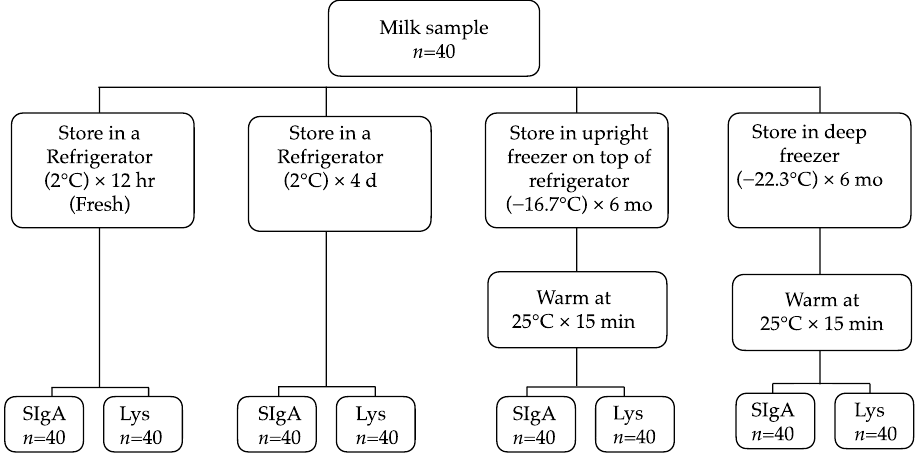
Figure 1. Diagram of the study protocol. Lys, lysozyme; SIgA, secretory immunoglobulin A.